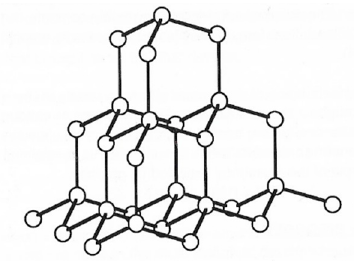
Figure 2. Structure of diamond.